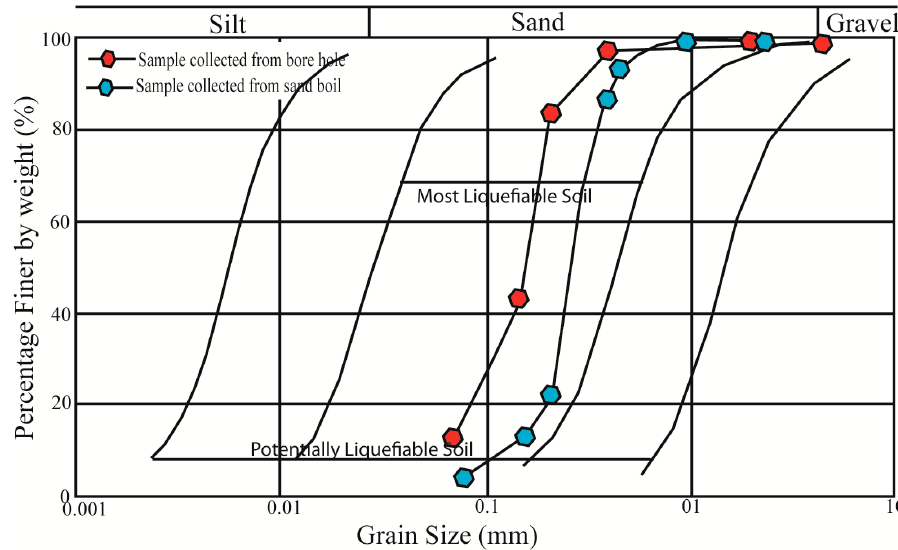
Figure 6. Grain size distribution graph for the samples collected from the ejected sand boils and drilled borehole. The grain size distributions were compared with the range of grain size distribution for liquefiable soil (Modified from [52]).